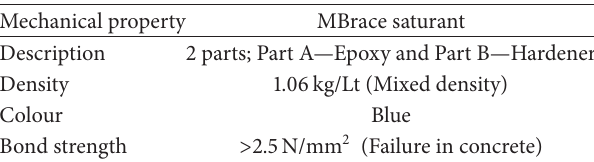
Table 3: Typical properties of MBrace saturant.